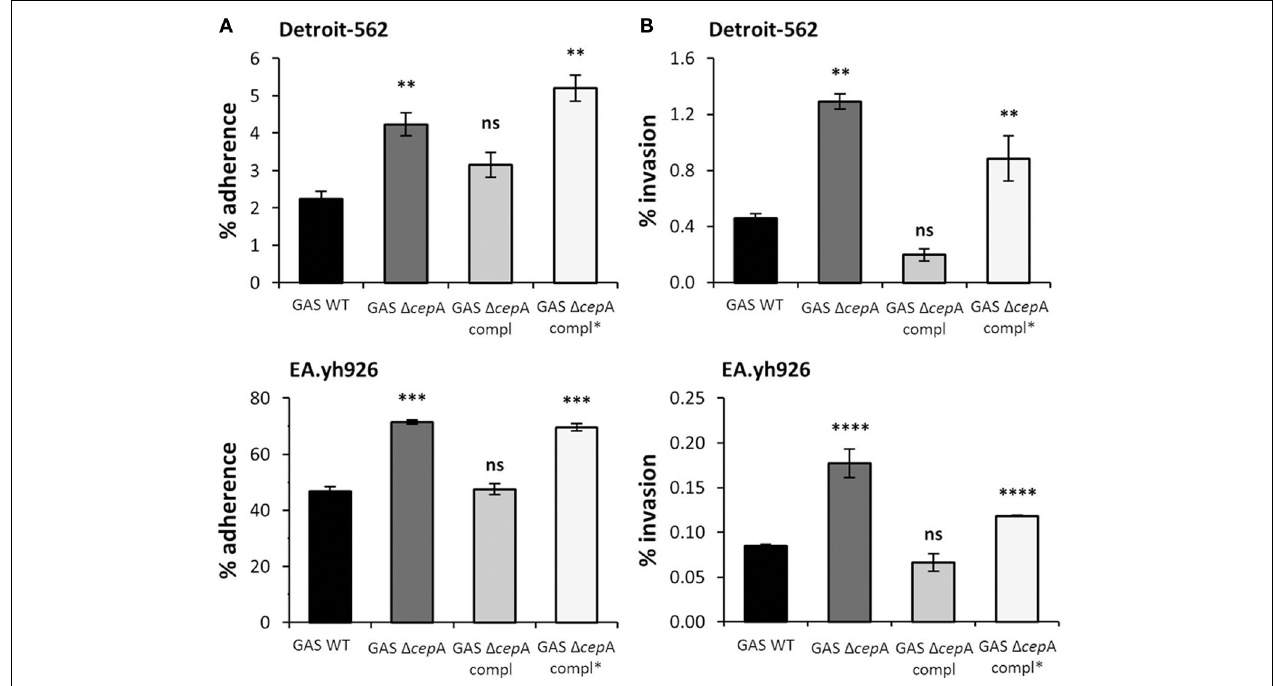
adherence and invasion to Detroit-562 and EA.hy926 cells. Each experiment was carried out in triplicate and the graphs show one representative experiment. Error bars represent the standard error, statistical analysis was carried out using a two-tailed t -test (ns = p > 0 . 05, ∗ p ≤ 0 . 05, ∗∗ p ≤ 0 . 01, ∗∗∗ p ≤ 0 . 001, ∗∗∗∗ p < 0 . 0001). The p -values are relative to GAS